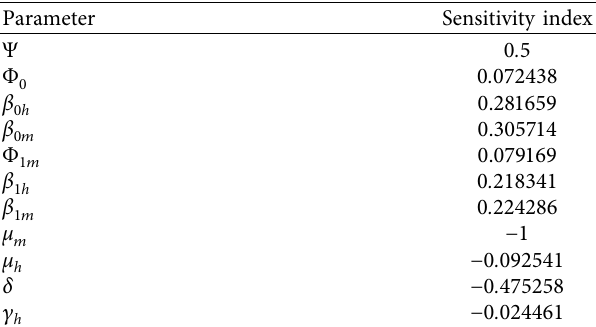
Table 3: Sensitivity indices of